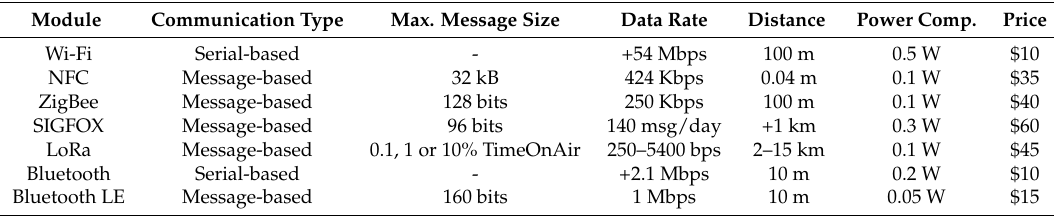
Table 6. Comparison of different network module